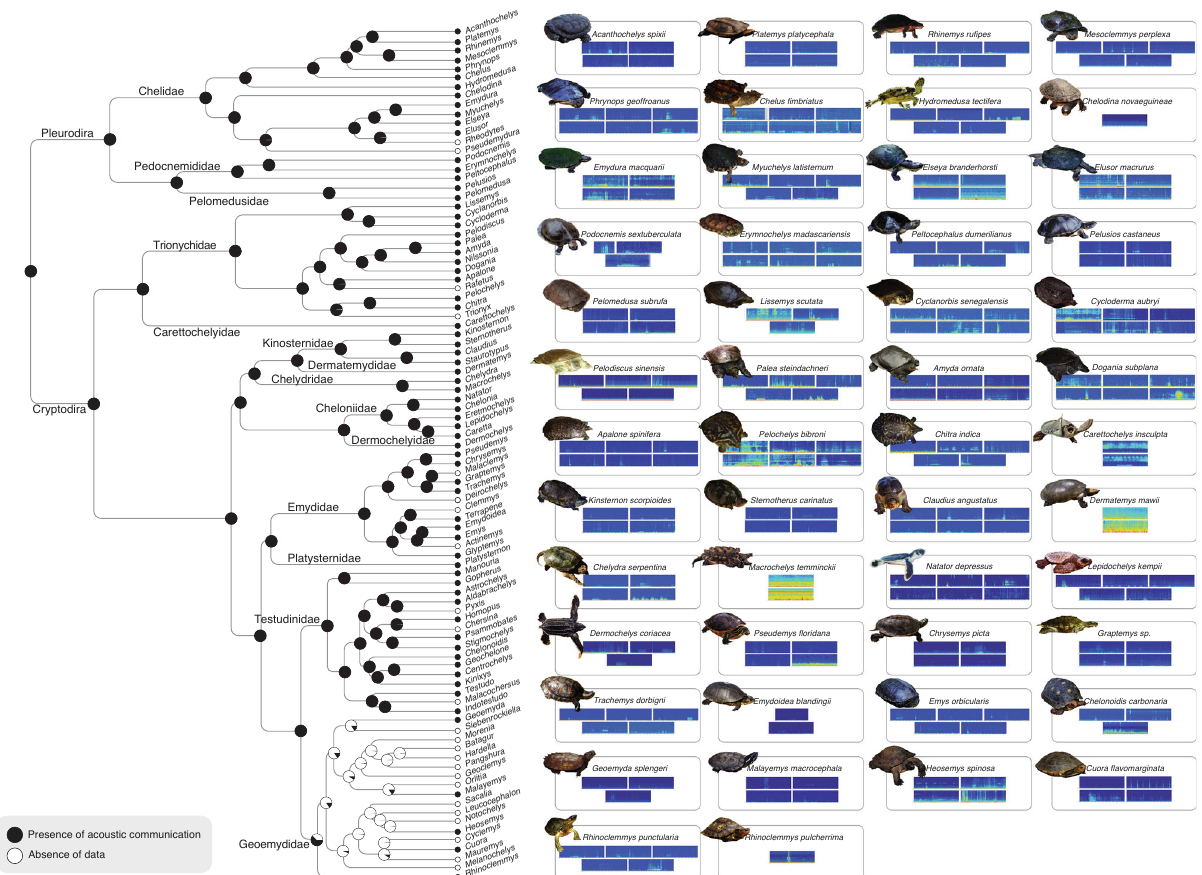
Fig.2|Turtleacousticcommunicationancestral-statereconstructionanalysis. Tree includes every turtle genus assigned either with the character presence or absence of acoustic communication. Pie charts at ancestral nodes indicate the likelihood of each character state. Colours in the spectrograms represent sound